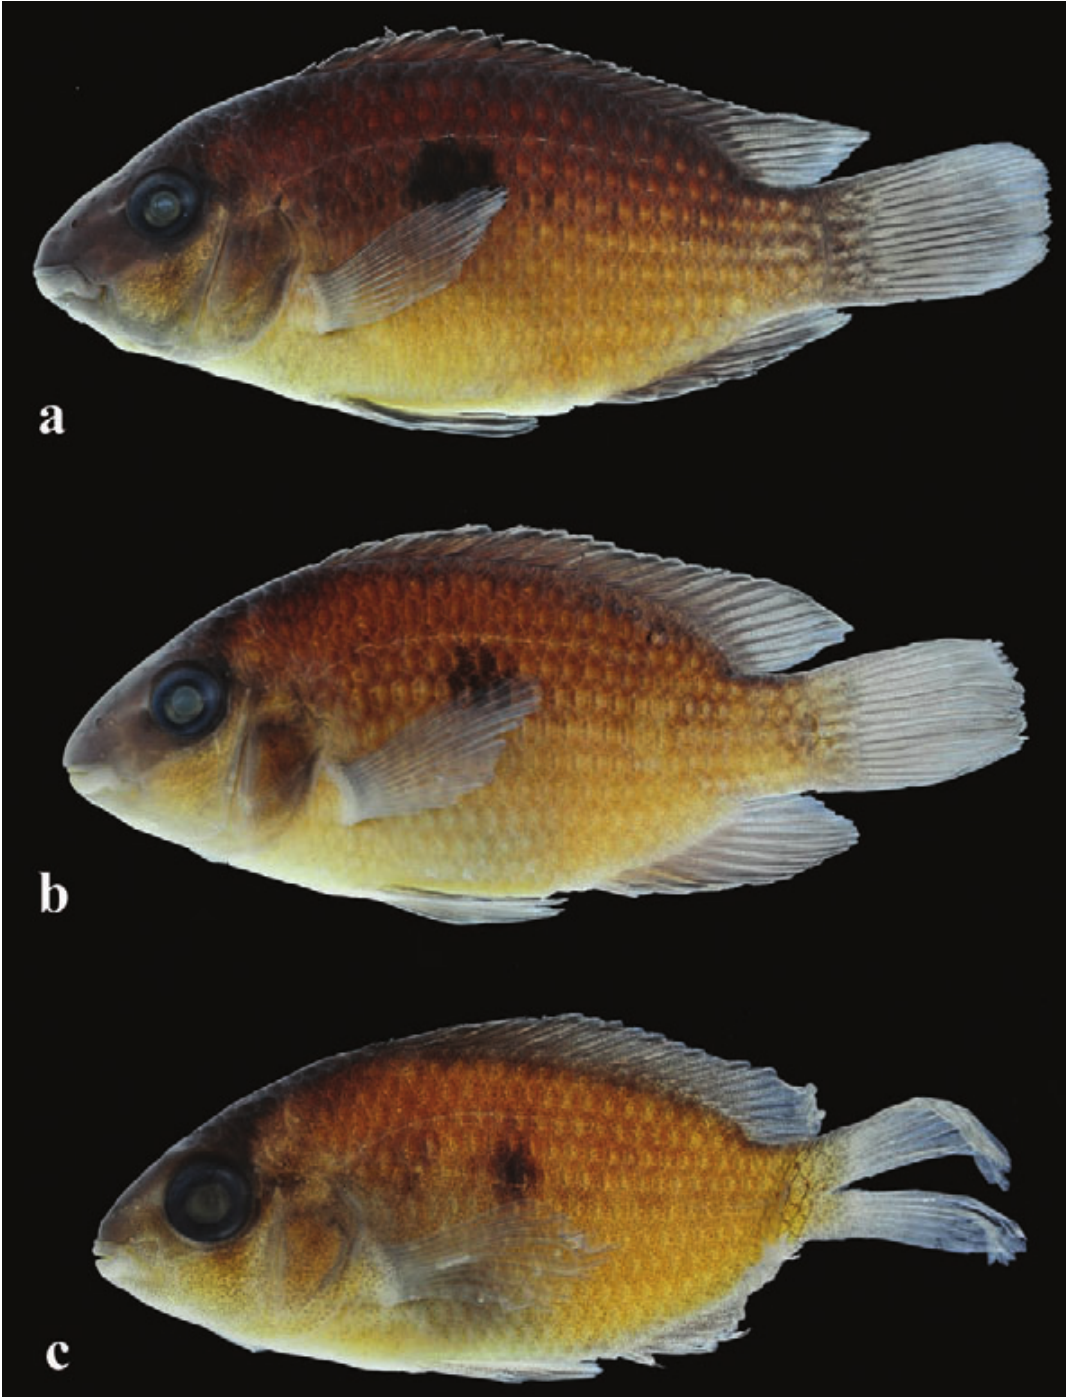
Fig. 12. Ontogenetic changes in body shape and coloration in Mazarunia pala . a ) Paratype, 52.2 mm SL, ROM 89737, b ) 39.9 mm SL, ROM 89737, c ) 21.0 mm SL,